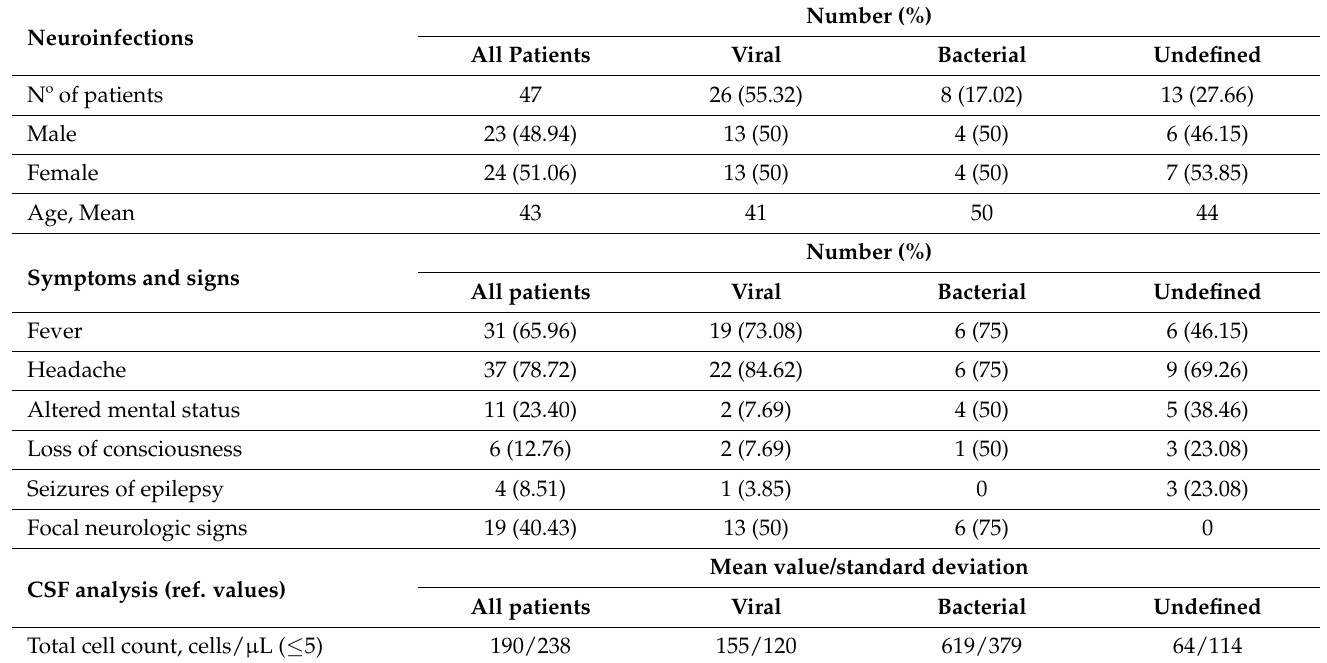
Table 1. Demographical, clinical, and laboratory data in 47 patients with neuroinfection and 20